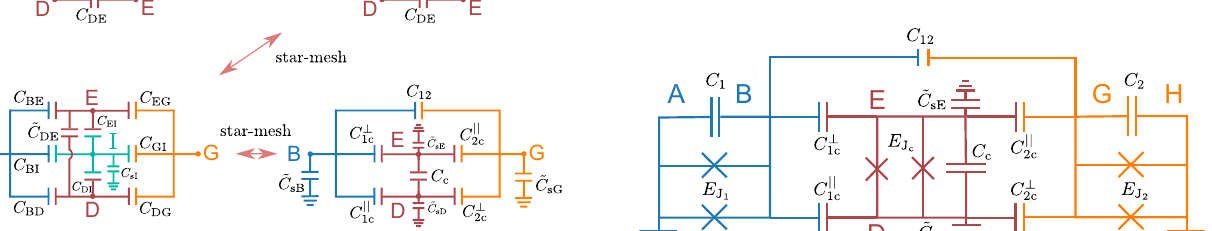
FIG. 7. The effective-circuit schematic of the floating-coupler setup. The capacitances are defined in Eq.